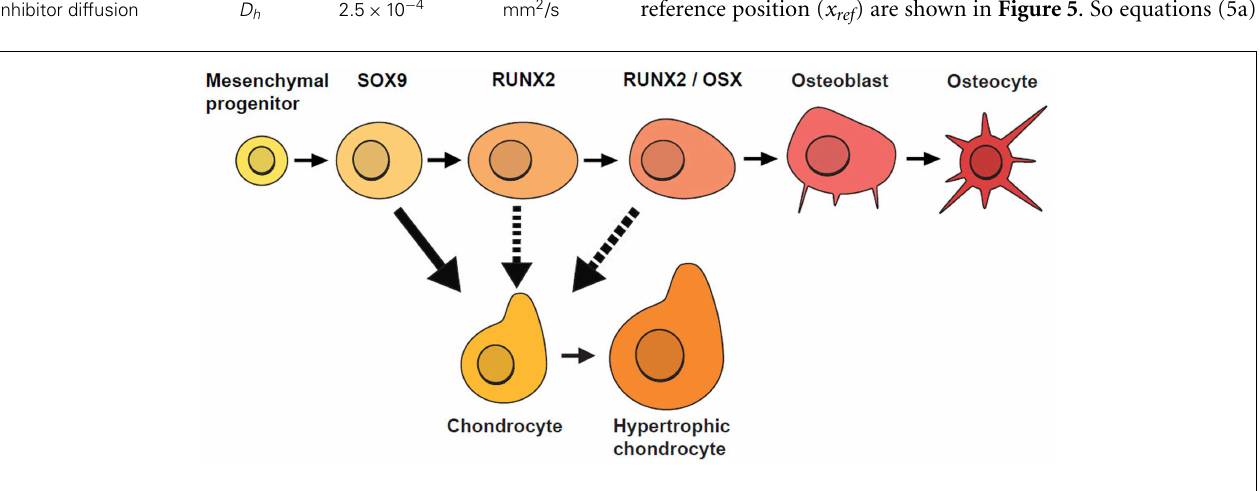
they are marked progressively by the expression of RUNX2, followed by OSX. Additional evidence suggests that SOX9 + cells can switch fates under certain conditions (indicated by dotted lines) [adapted from Long